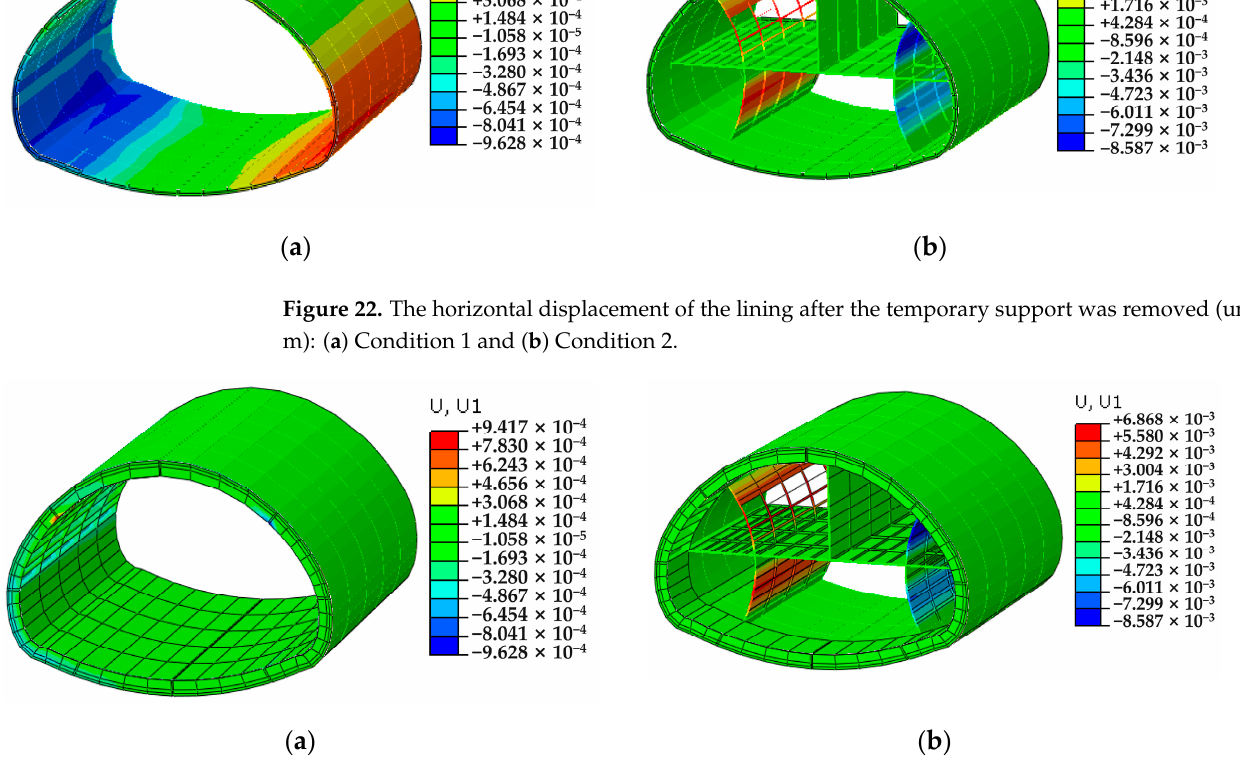
Figure 23. The horizontal displacement of the lining after the construction of the secondary lining (unit: m): ( a ) Condition 1 and ( b ) Condition